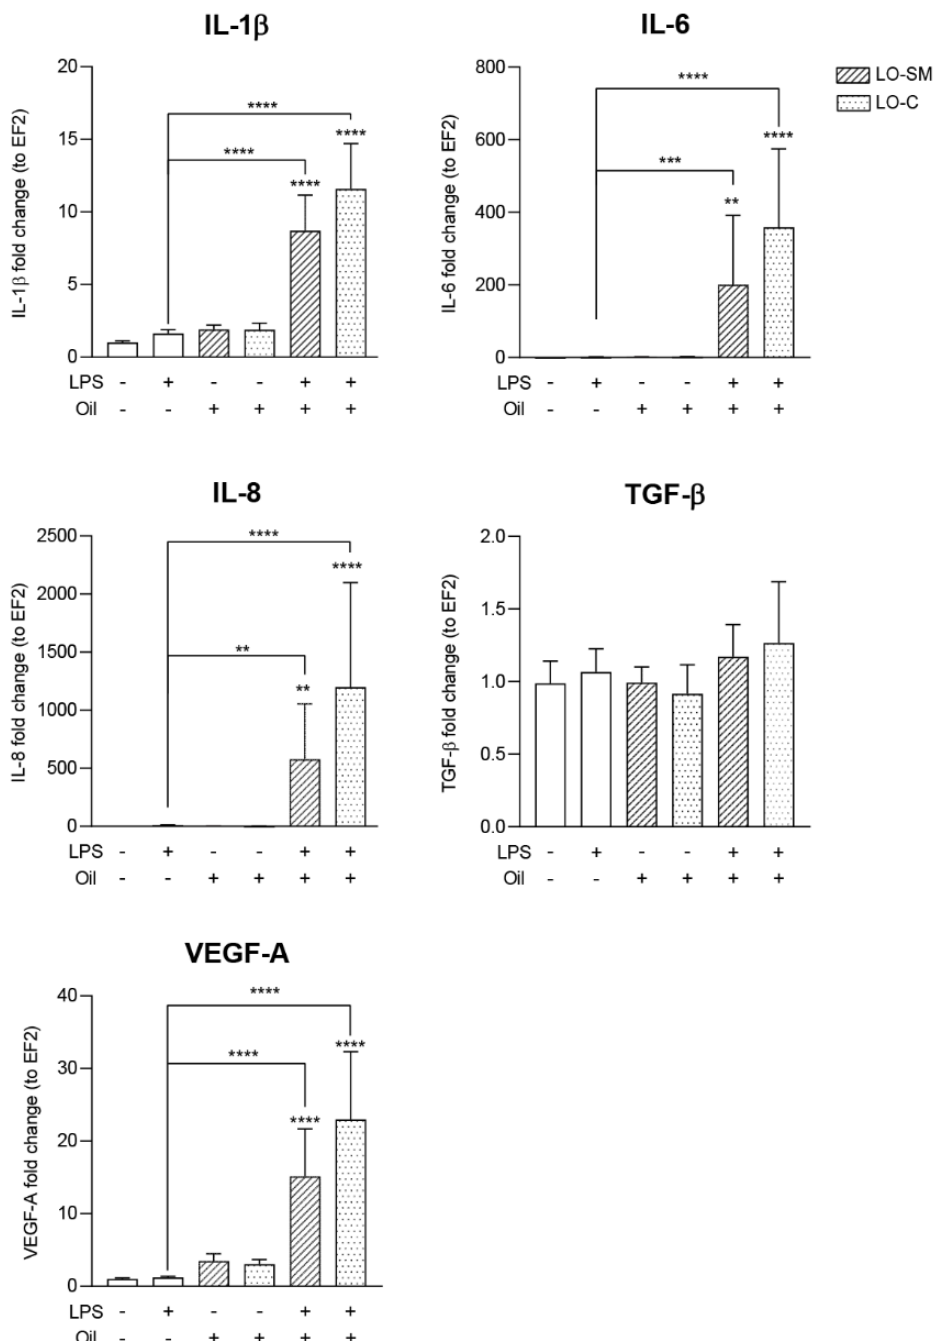
Figure 7. Effect of co-stimulation with lavender oil and bacterial LPS on the cytokines production in HaCaT cell line. HaCaT cells were stimulated with 0.01% of commercial or in-house preparation of lavender oil and 5 ug/mL of Escherichia coli LPS for 4 h. Level of mRNA production of cytokines: IL-6, IL-8, TGF- β , and VEGFA were verified with ELISA. Values are mean ± SD. Groups were compared to the control, and statistical analysis was performed using GraphPad Prism and build-in ANOVA test. Individual comparisons between groups are indicated by the gates. p -values ≤ 0.05 were considered significant. **— p ≤ 0.01; ***— p ≤ 0.001; ****— p ≤ 0.0001.